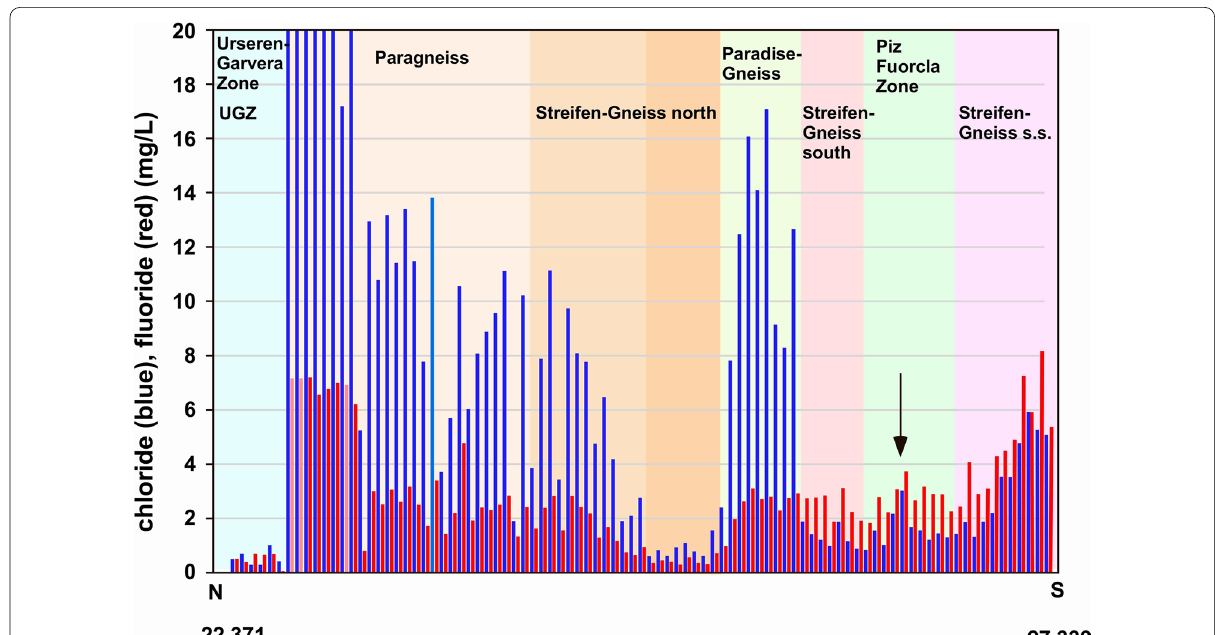
Fig. 15 Chloride and fluoride concentration (mg L − 1 ) measured in Gotthard-Massif inflows in the Gotthard Base Tunnel (Sedrun